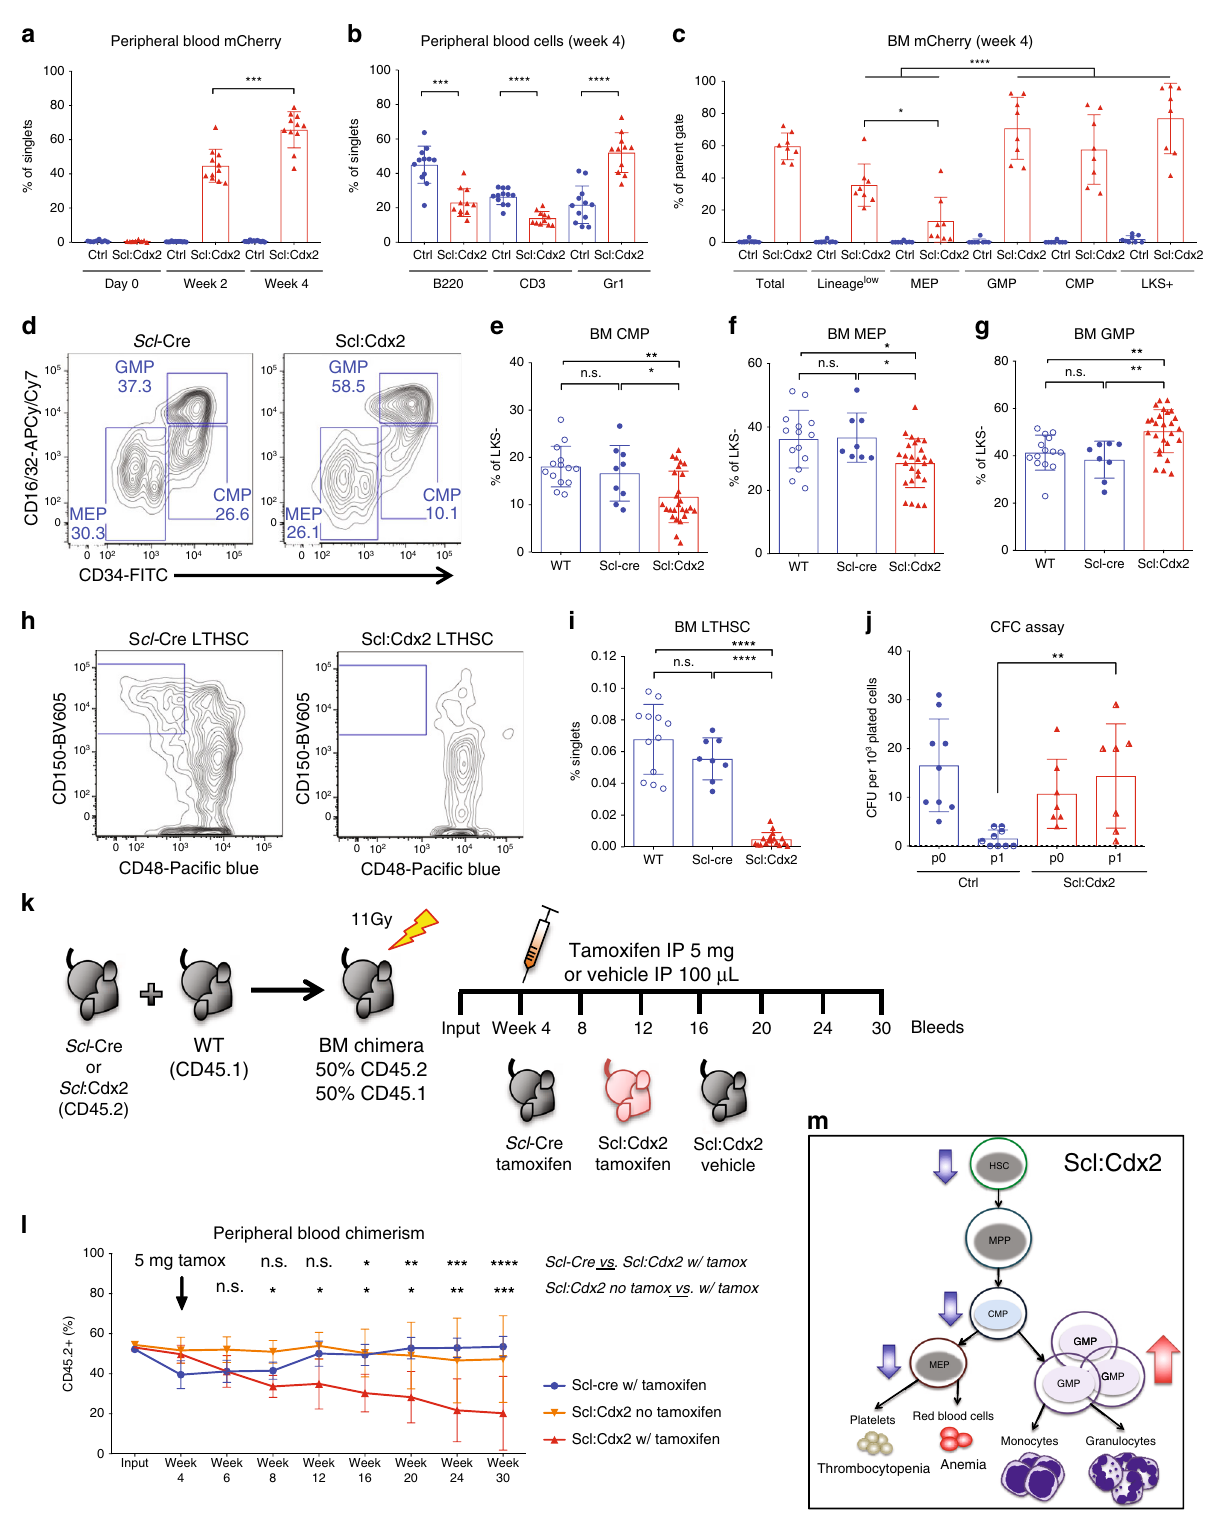
competitive BM transplantations using Scl-CreER T or Scl:Cdx2 donor BM (expressing CD45.2) from uninduced (naïve) mice, mixed with congenically marked competitor wild type (WT) BM (expressing CD45.1) (Fig. 1k). There was equivalent engraftment of donor cells of both genotypes four weeks after transplantation in the absence of tamoxifen. Induction of Cdx2